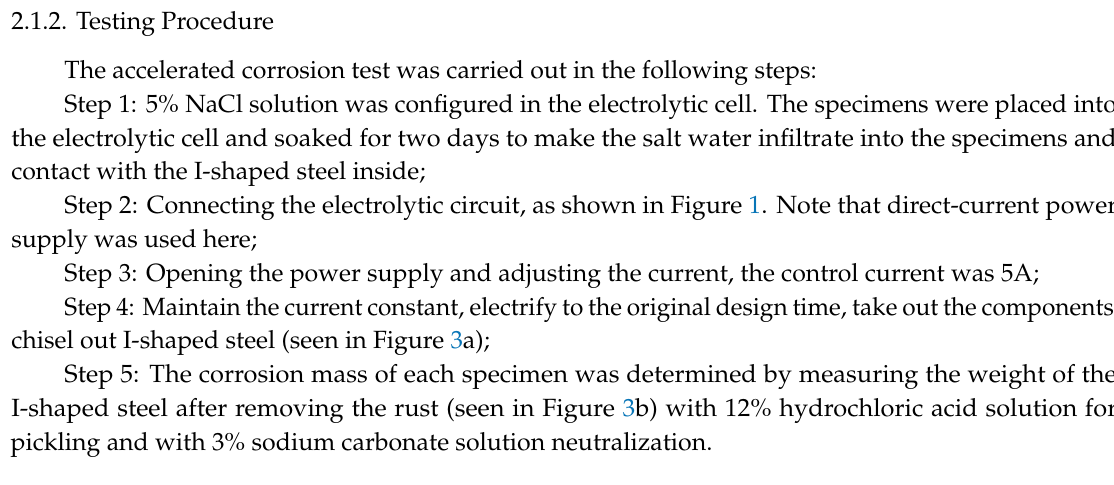
Figure 2. Schematic diagram of specimens (unit: cm). ( a ) Longitudinal section; ( b ) Cross section.